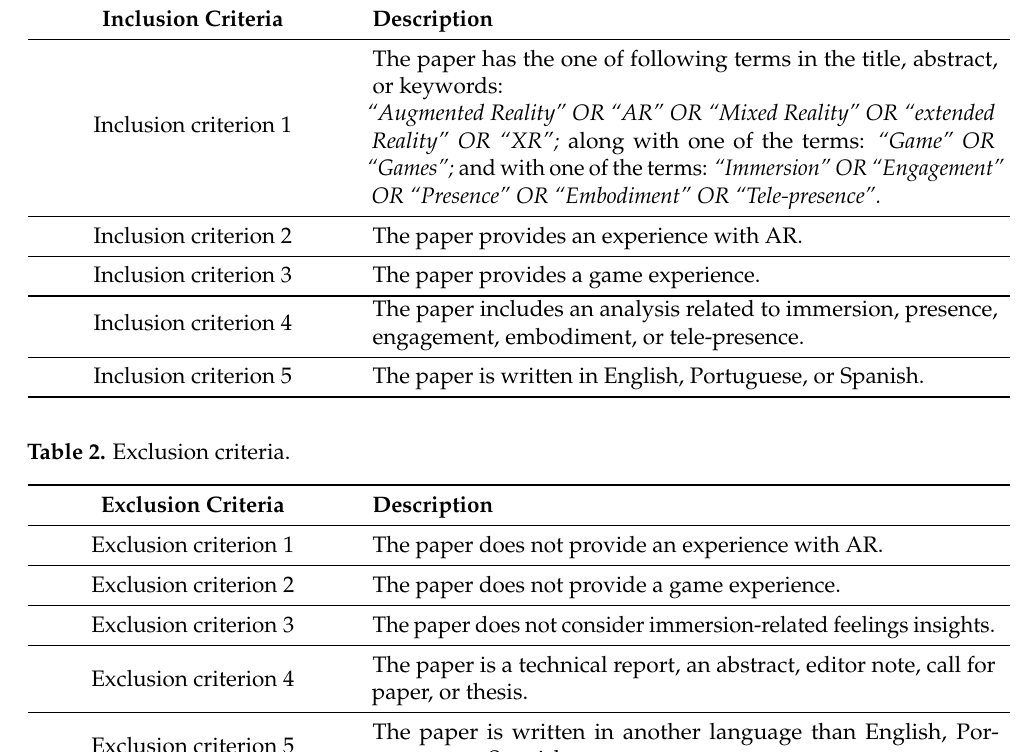
Table 1. Inclusion criteria.